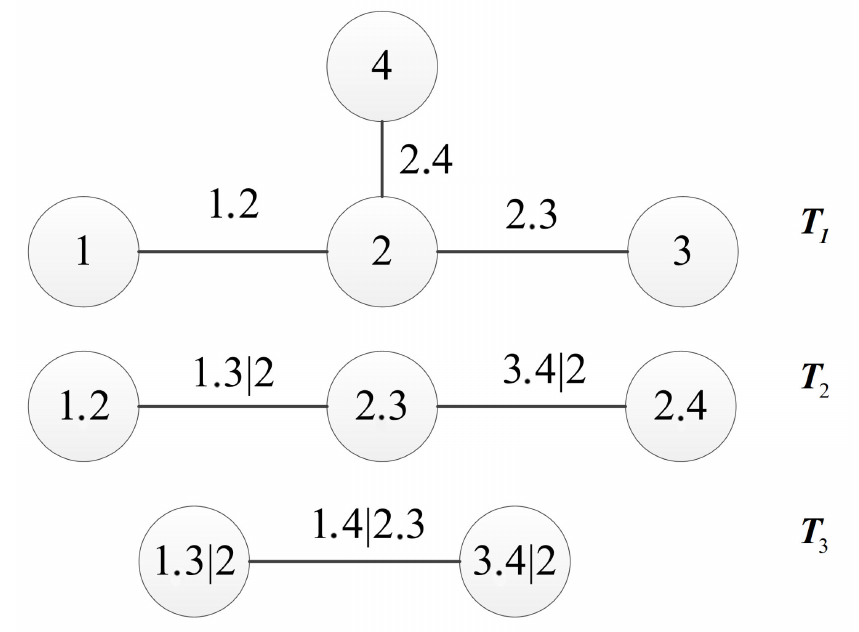
Figure 2. A four-dimensional R-vine copula